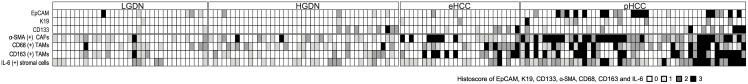
The heatmap presenting expression of EpCAM, K19, CD133, α-SMA (+) CAFs, CD68 (+) TAMs, CD163 (+) TAMs, and IL-6 (+) stromal cells in B viral multistep hepatocarcinogenesis.Histoscores of each marker are presented in the individual case of LGDNs, HGDNs, eHCCs and pHCCs.